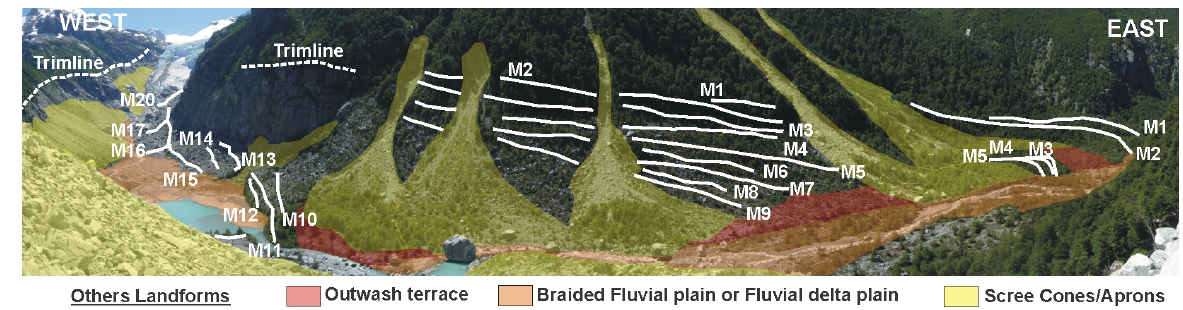
Fig. 2. Panoramic view of the upper R´ıo Esperanza valley seen from the south. Glaciar Esperanza Norte is on the far left and the moraines are indicated with white lines (see also Fig. 3). Note the distortion of the view due to the curvature of the valley. The distance between M1 to M11 is ca. 1.24km and the distance between M11 and the glacier front is ca. 2.4km. The location where the photo was taken is shown in Fig.